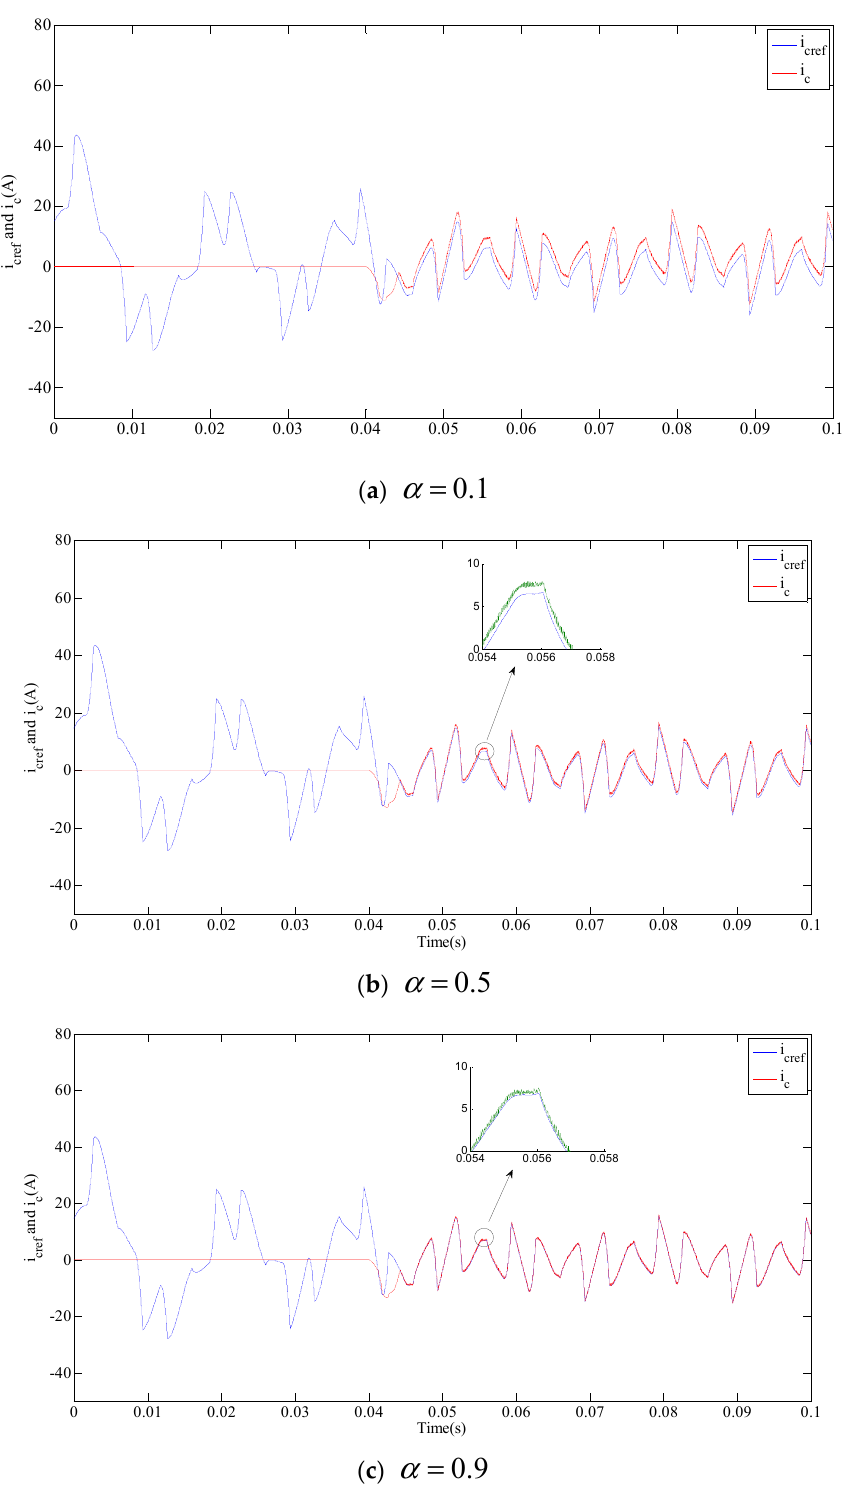
Figure 6. Instruction current and compensation current with different values of fractional order.